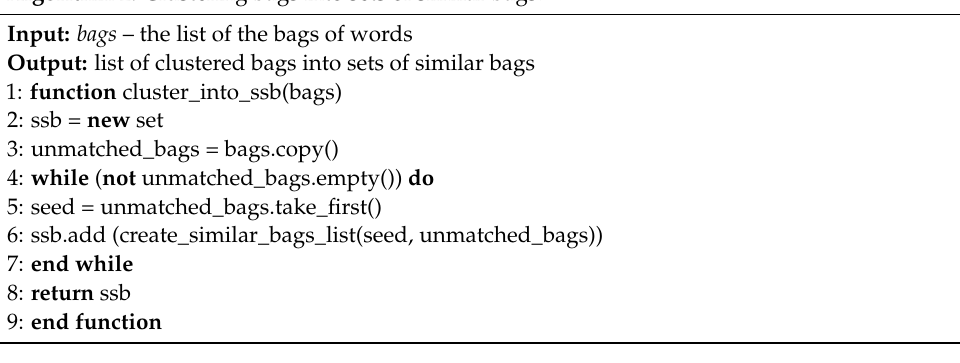
Algorithm 2: Clustering bags into sets of similar bags.